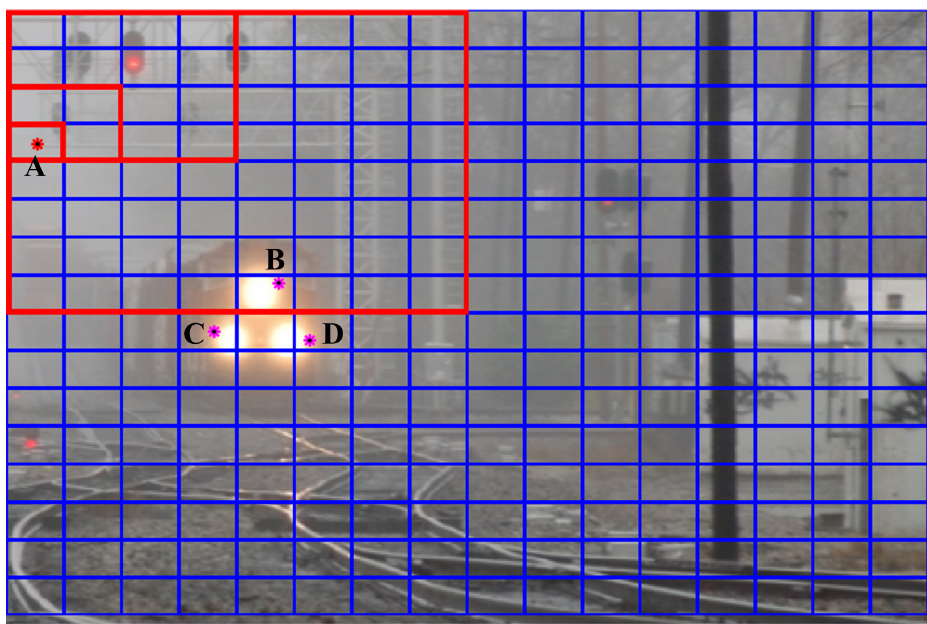
Figure 8. (A) Atmospheric light pixel and (B, C, and D) pixels surrounding the train’s headlight. Table 1. Red-Green-Blue (RGB) values of atmospheric light pixel and pixels surrounding the train’s headlight. RGB Values Pixel Before Dehazing After